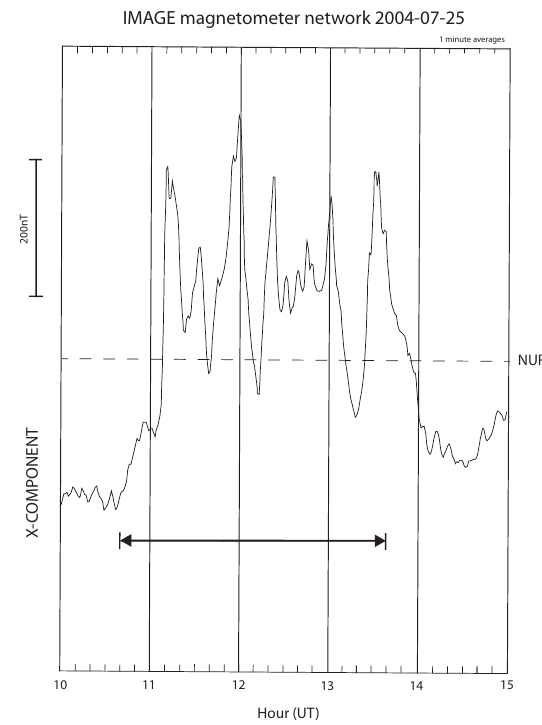
Figure 5. IMAGE chain H component magnetogram from station NUR (56.9 ◦ MLAT) during the interval